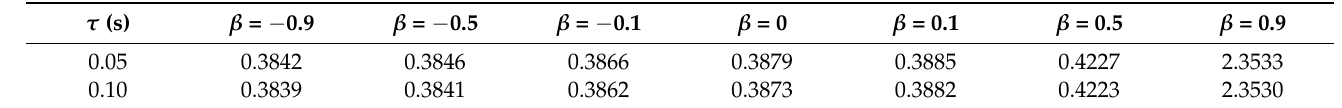
Table 12. Root mean squared value of the control signal u 4 in the first 30 s under different input time delays and different fractional orders in the proposed controller.